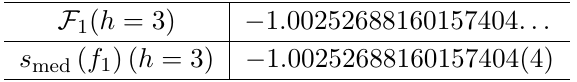
Table 1 . Comparison between the exact result and the median resummation of the perturbative series for h = 3 and m set to 1. The error in the Padé-Borel resummations of the first 41 terms of the perturbative series is estimated from the convergence of the